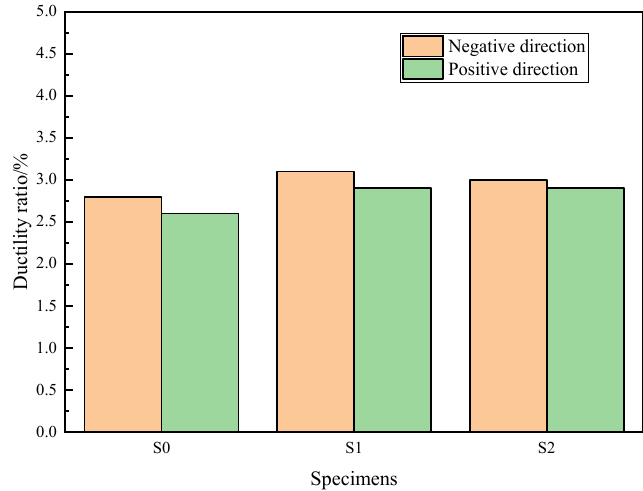
Figure 14. Ductility ratio values of the